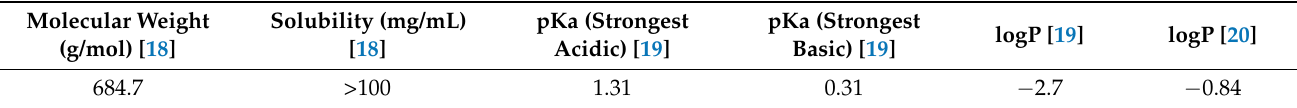
Table 1. Physicochemical properties of